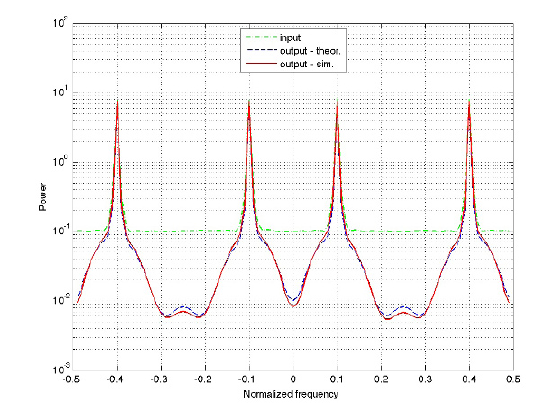
Figure 3. Line enhancer output signal